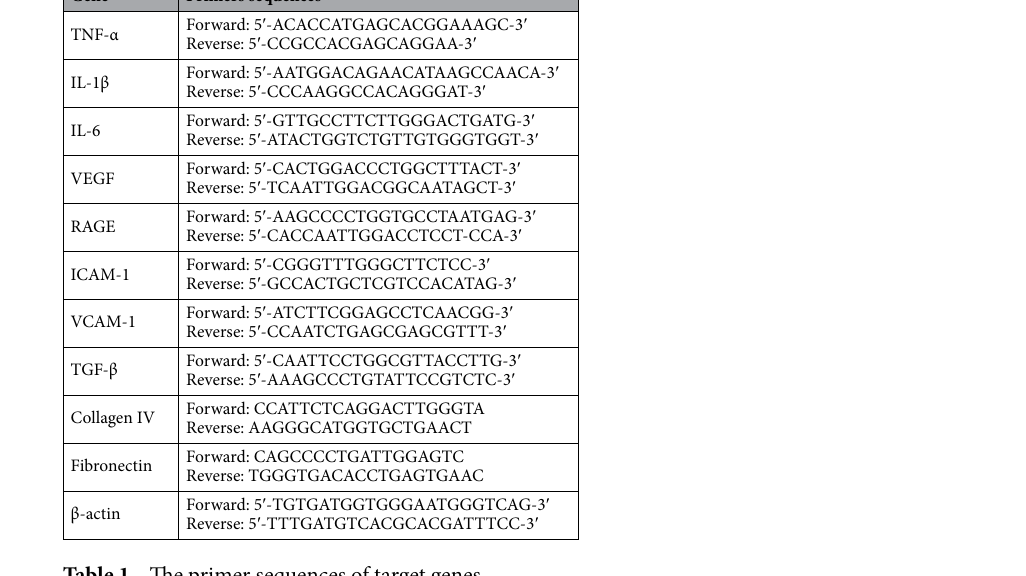
Table 1. The primer sequences of target